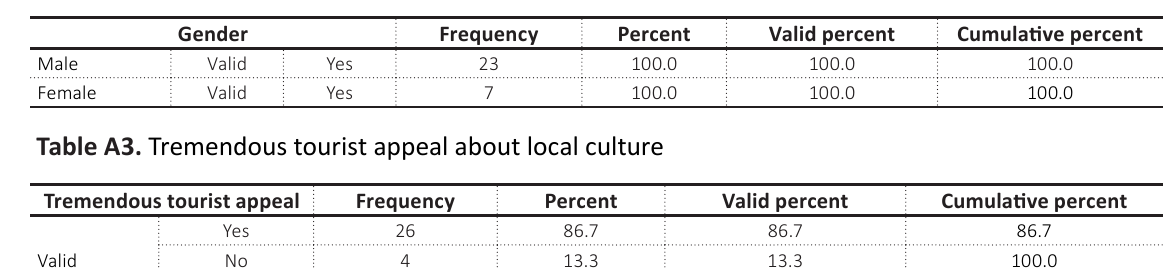
Table A2. Benefits from ecotourism activities